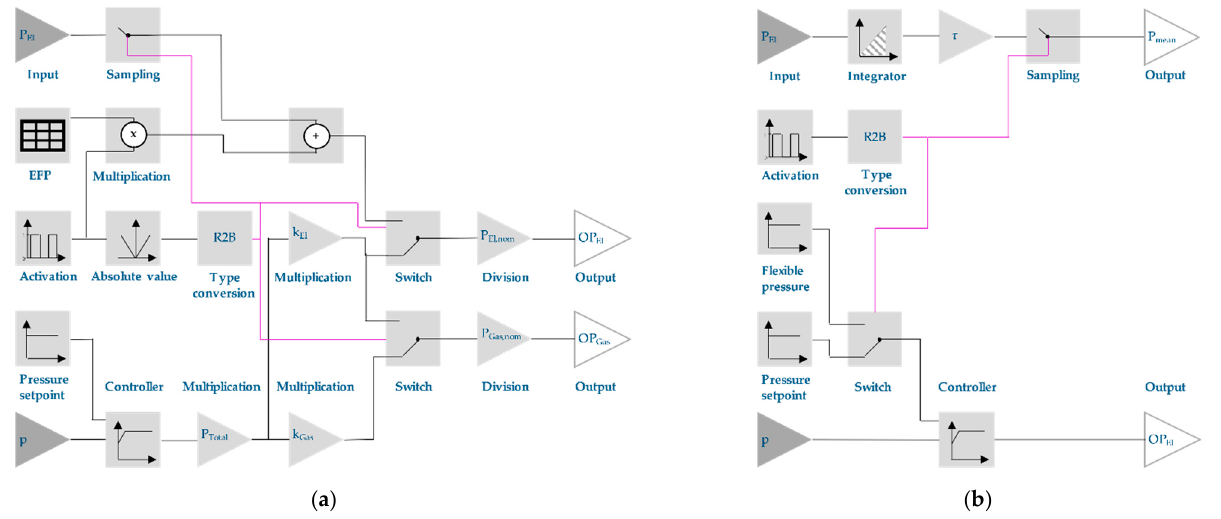
Figure 2. Evaporator control mechanisms: ( a ) Simulating bivalence; ( b ) Storing energy inherently.